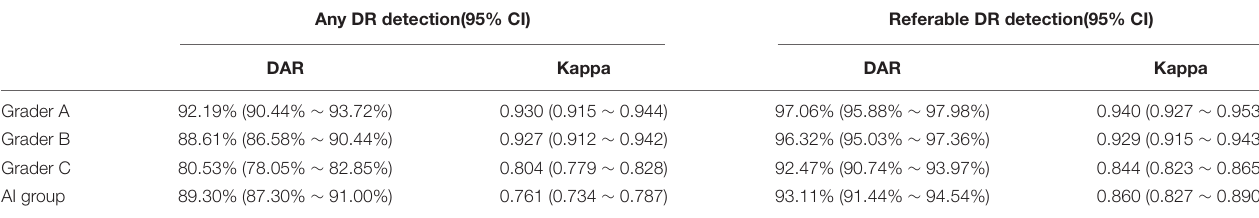
TABLE 3 | The DAR and kappa between AI software, every grader (A,B,C) and gold standard for detecting any DR and referable DR.